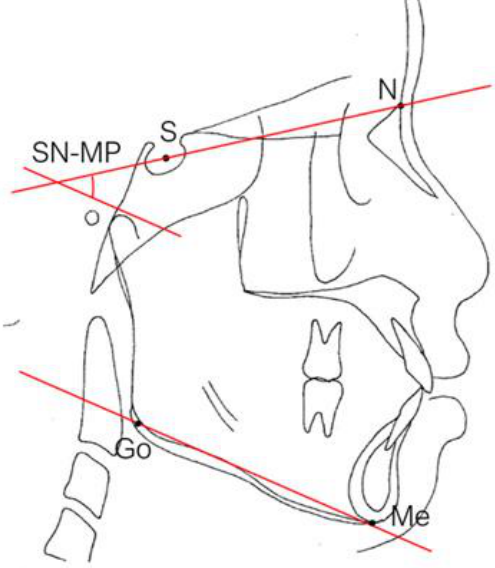
Figure 6. SN plane to the mandibular plane angle (SN–MP). S: sella, the midpoint of the sella turcica. N: nasion, the most anterior point of the intersection between the nasal and frontal bones (frontonasal suture). MP: mandibular plane: formed by connecting Go to Me. Go: gonion: the most posterior and inferior point on the angle of the mandible. Me: Menton, the most inferior point on the